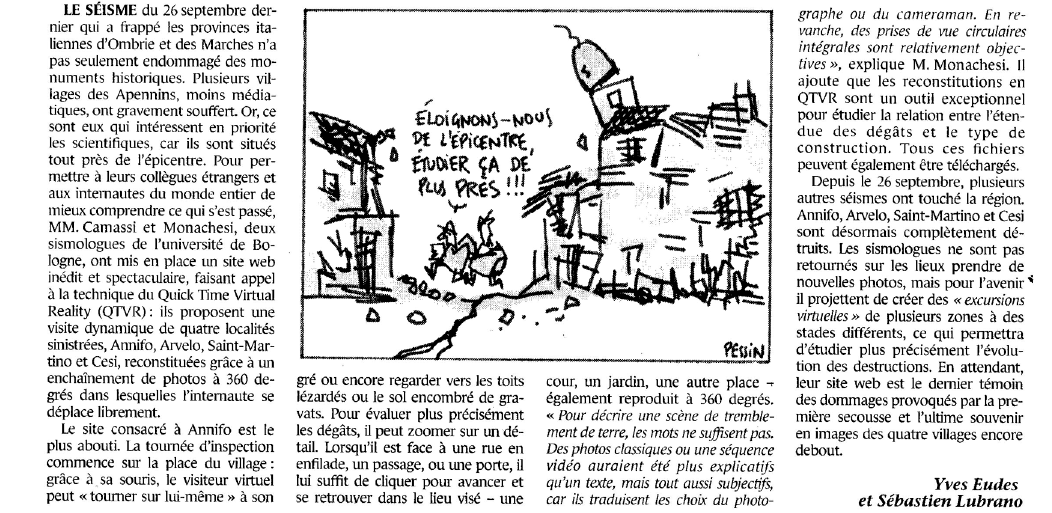
Fig. 4. Paper by Yves Eudes et Sébastian Lubrano appeared on Le Monde, October 22, 1997, dealing with the «virtual» exploration of the epicentral